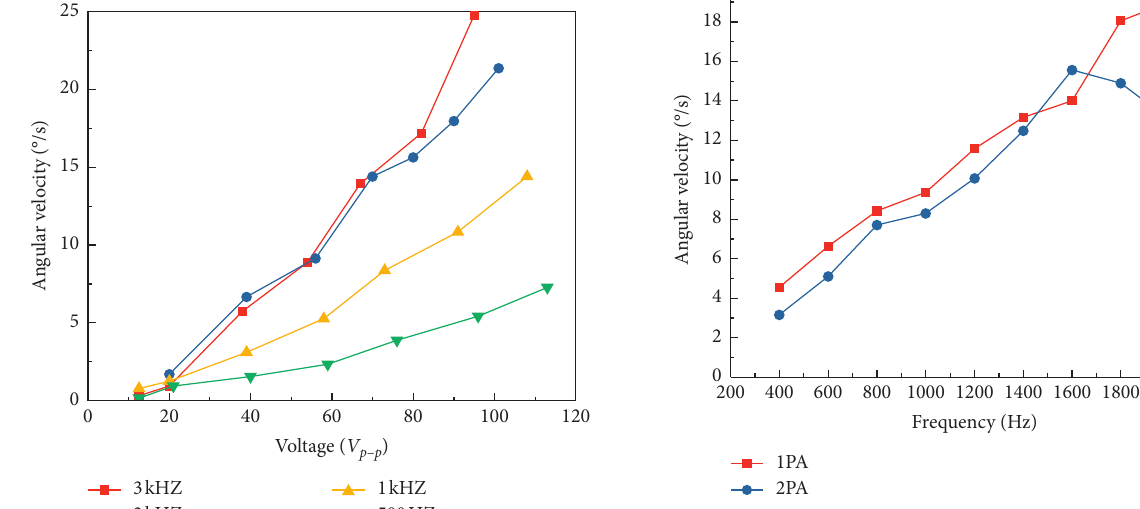
Figure 16: Driving by a sawtooth wave signal with 93 Vp-p at different